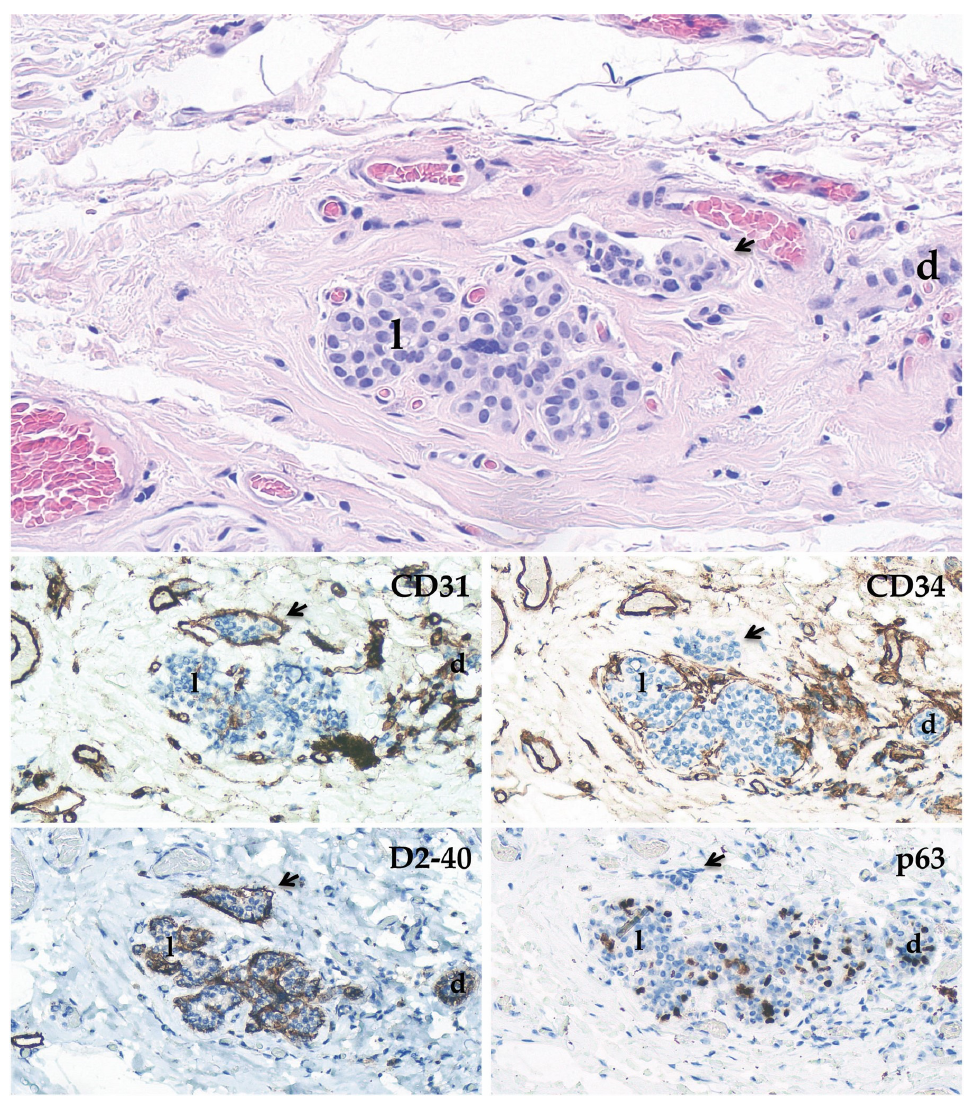
Figure 2. LVI (arrow) adjacent to a non-neoplastic lobule (l) and a small duct (d). The immunohisto- chemical staining demonstrates an endothelial layer (CD31+, CD34 − , D2-40+, and p63 − ) surrounding the LVI embolus. Both the l and d show an irregular positivity for CD31, CD34, and faint D2-40 that can simulate LVI, particularly in small structures like d; however, positivity for p63 identifies myoepithelial cells of the terminal duct-lobular unit (200× magnification). Again, the significant attenuation of the stretched endothelial cytoplasm in dilated lymphatic channels may be responsible for the apparent false-negative immunostaining of lymphatic endothelial cells [21]. Taking these findings together, caution should be taken while using immunohistochemical stains to identify LVI.